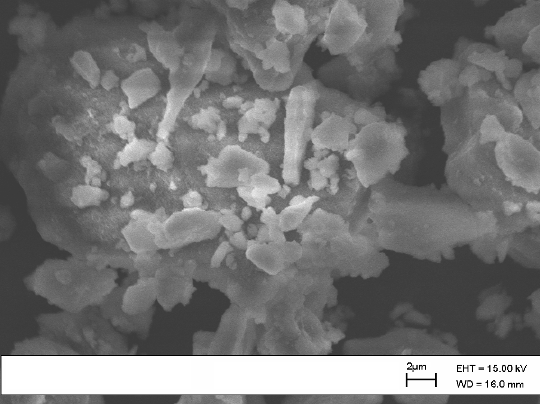
Figure 7. SEM micrograph of Mg/Ni/Al in